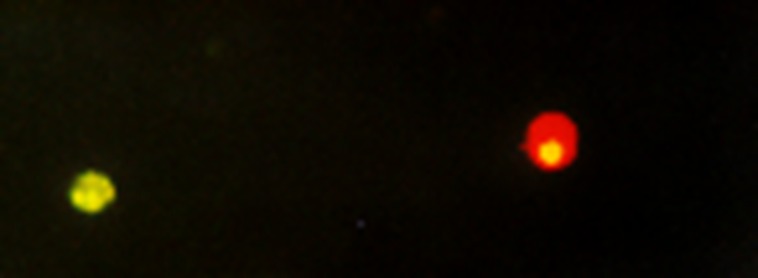
Annexin V/PI Staining of HNSCC cells.Results obtained by fluorescence microscopy show that early apoptotic cells have bound Annexin-FITC to the phosphatidylserin on the membrane surface (green cell). As apoptosis progressed, the plasma membrane integrity gets lost, and the propidium iodide is able to bind to nucleotid DNA, so that late apoptotic or necrotic cells appear in red.